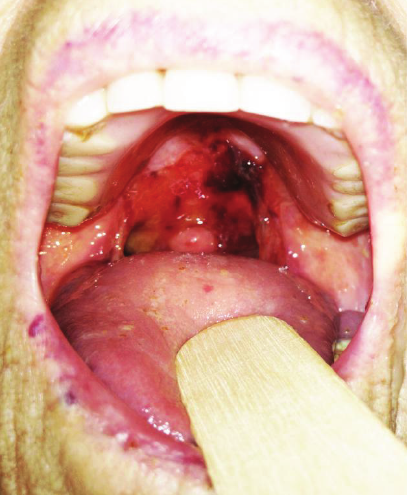
Figure 1: Haemorrhagic ulcer on soft palate resulting from a deroofed blister; in BP oral involvement is usually minor with blisters which break easily. Photograph was obtained with patient’s written consent for publication.